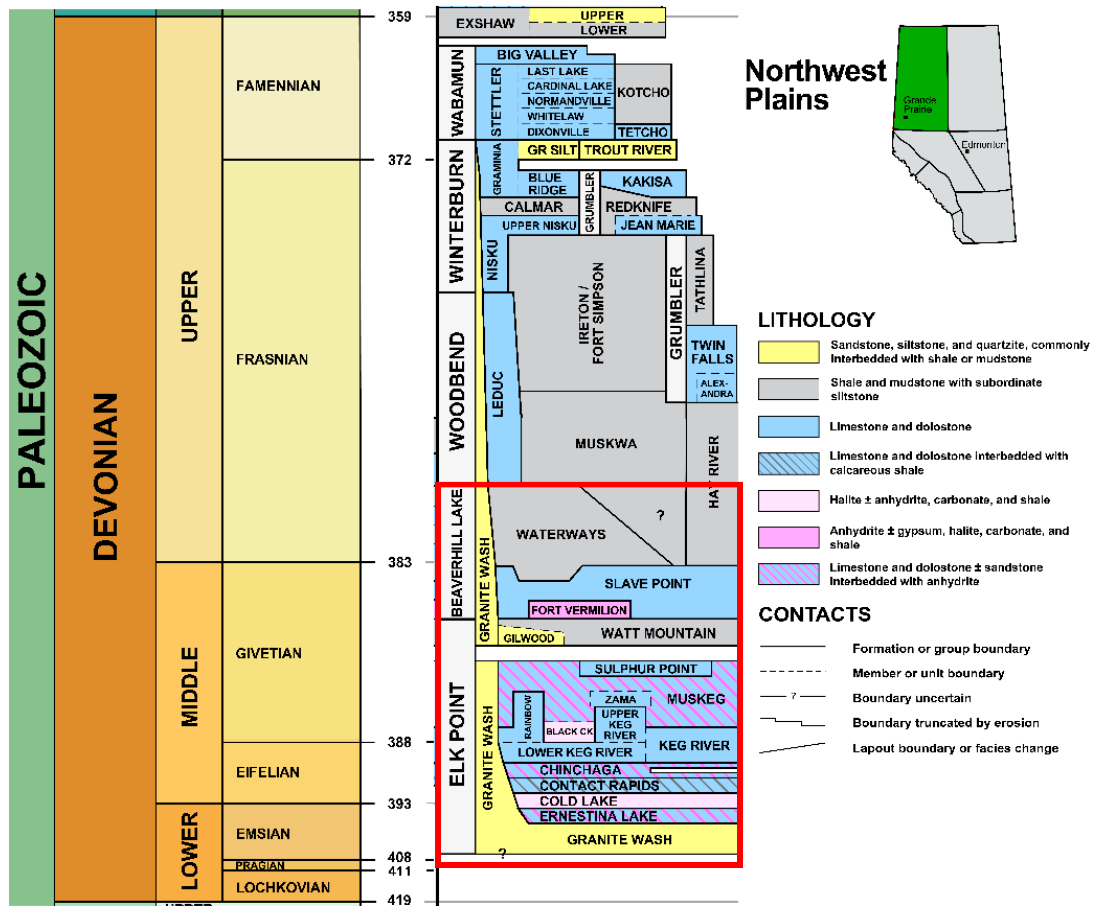
Figure 3. General stratigraphy of Devonian units in the Northwest Plains of Alberta. The Alberta No. 1 project area is not underlain by all the units depicted, but is targeting the formations from the Beaverhill Lake Group to the Granite Wash Formation, outlined in red [3].